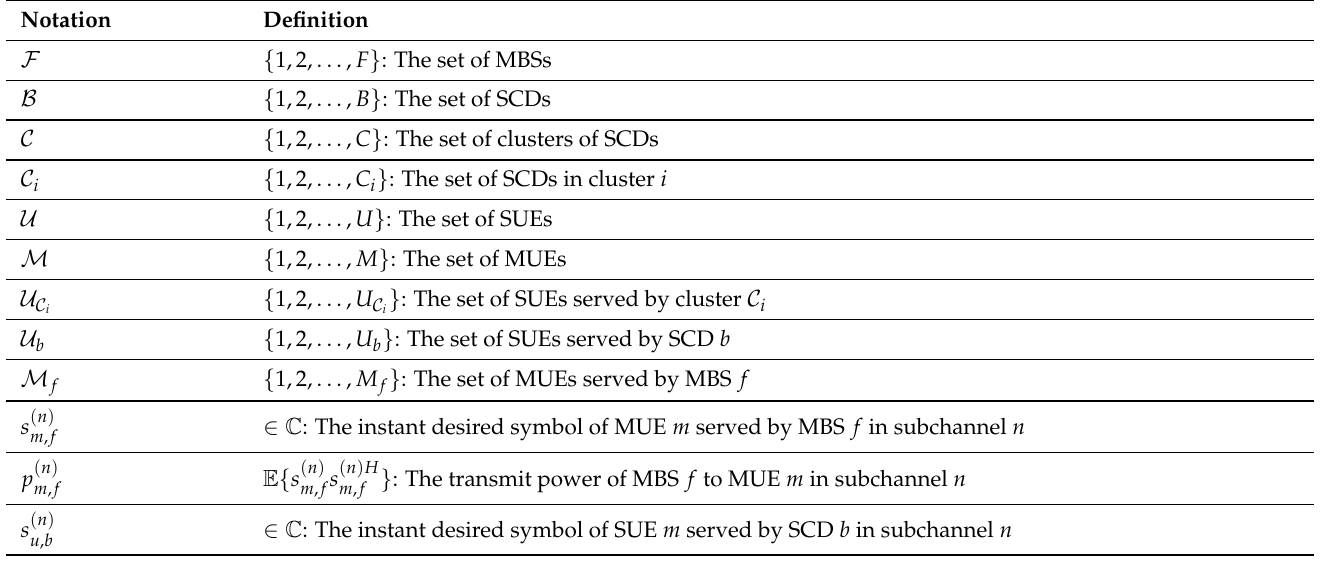
Table 1. The description of the main mathematical